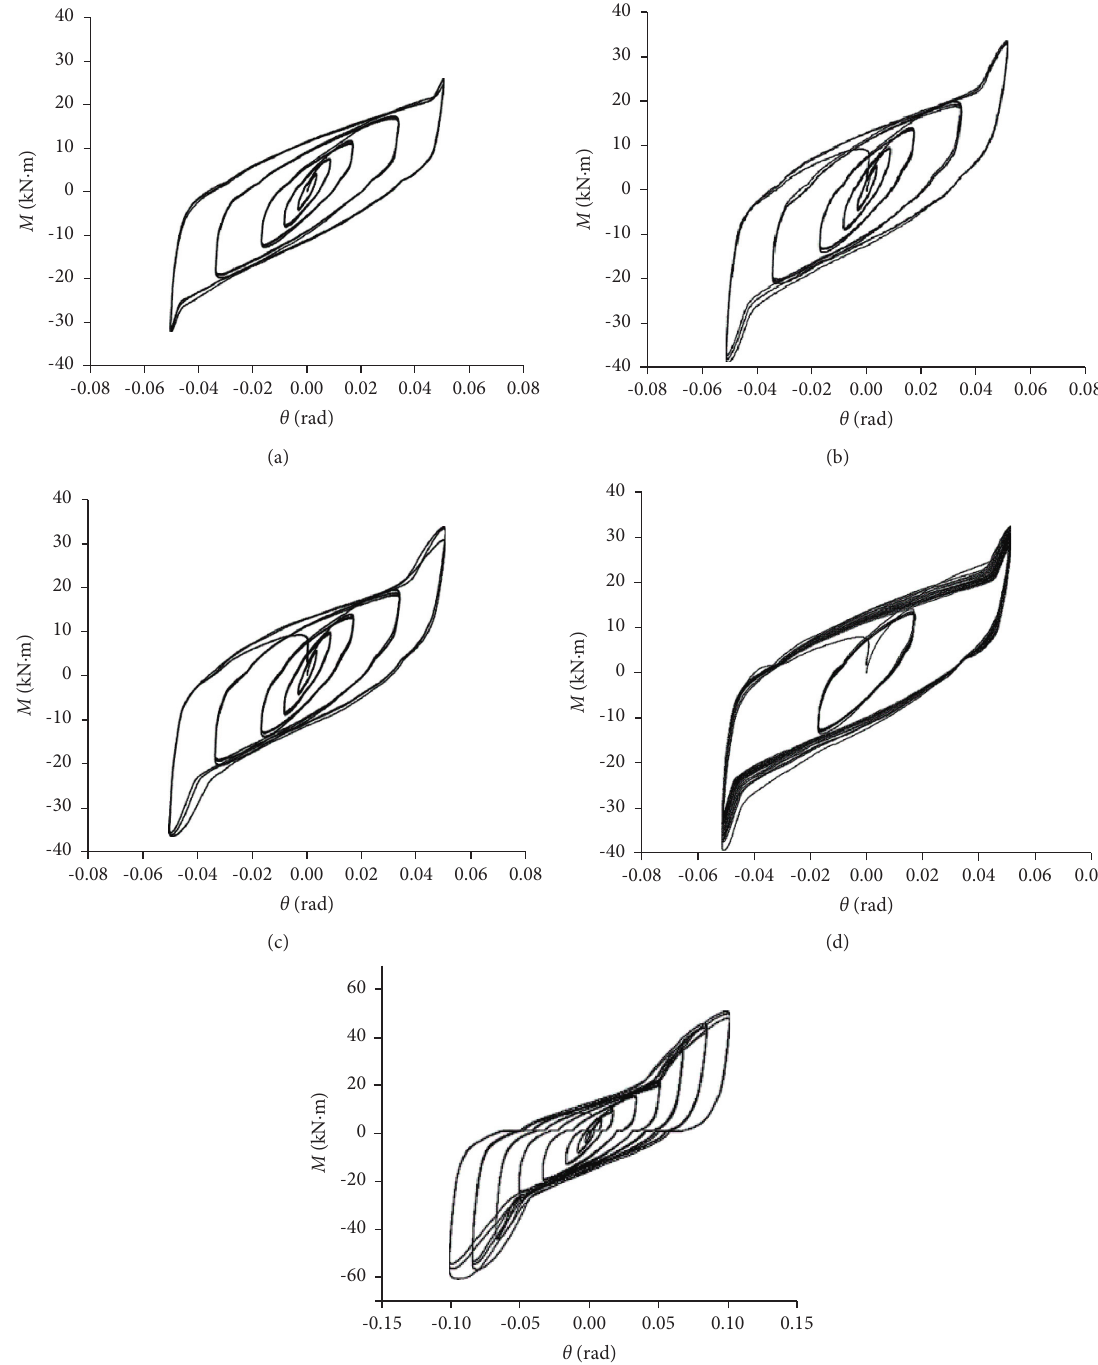
Figure 11: Hysteresis loops of the specimen under cases 1–5. (a) Case 1. (b) Case 2. (c) Case 3. (d) Case 4. (e) Case